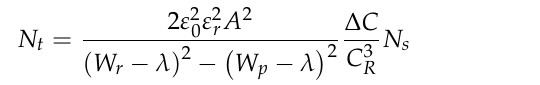
Figure 2. Schematic structure of ( a ) deep-level transient spectroscopy (DLTS) samples and ( b ) up- right rear-heterojunction GaAs solar cells; ( c ) photograph of the solar cell device.